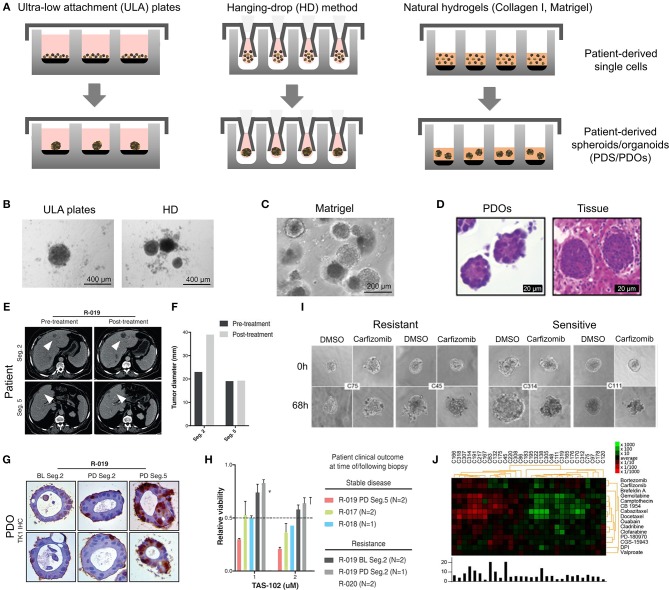
Patient-derived organoids/spheroids (PDO/PDS). (A) Schematic diagram displaying the key techniques utilized in current literature for the culture of PDO and PDS. Left, ultra-low attachment (ULA) plates; Center, hanging drop method; Right, natural hydrogels. (B) Primary head and neck cancer cells can form consistent spheroids in ULA plates (left), but are not as reproducible in hanging drop culture (right) as visualized using phase contrast microscopy. (C) Phase contrast image of a colorectal cancer PDO cultured in Matrigel, and (D) hematoxylin and eosin staining comparing PDOs to their matching patient biopsy sample. (E–H) PDOs recapitulate intra- and interpatient heterogeneity in response to chemotherapeutics (TAS-102). (E) Spheroids were established from a patient with mixed response to TAS-102 with multiple metastases. (F) While the segment 2 metastasis rapidly progressed, the segment 5 metastasis remained stable upon TAS-102 treatment. (G) Thymidine kinase 1 (TK1) IHC expression is stronger in TAS-102-, compared to sensitive (segment 5) PDOs TAS-102-refractory (segment 2). BL, Core biopsy (baseline); PD, post-treatment (progressive disease). (H) There was no significant decrease in cell viability in PDOs in response to TAS-102 in resistant patients. (I,J) Diversity of sensitivities for drugs among colorectal cancer tissue-PDX spheroids assessed via high throughput screening. (I) Morphological changes after treatment with 100 nmol/L of carfilzomib. (J) Heat map and clustering analysis of the average IC50 of 15 drugs in the panel. (B,C–J) reproduced with permission from Hagemann et al. (2017), Vlachogiannis et al. (2018), and Kondo et al. (2018), respectively.